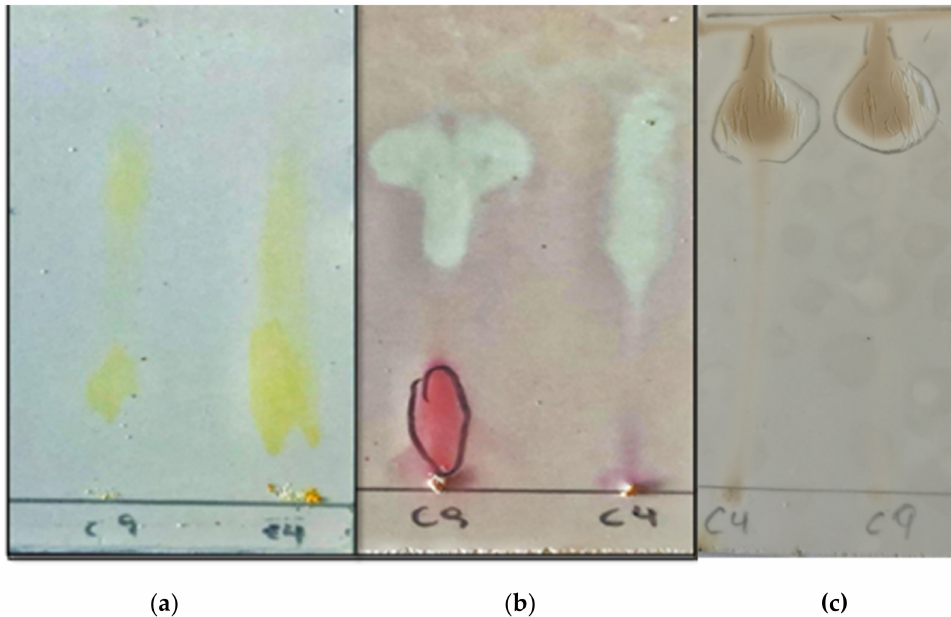
Figure 4. Thin layer chromatography (TLC) plates of purified biosurfactants of bacteria Pseudomonas rhodesiae strain C4 and Pseudomonas marginalis strain C9. Reactions with iodine ( a ), ninhydrin ( b ) and H 2 SO 4 ( c